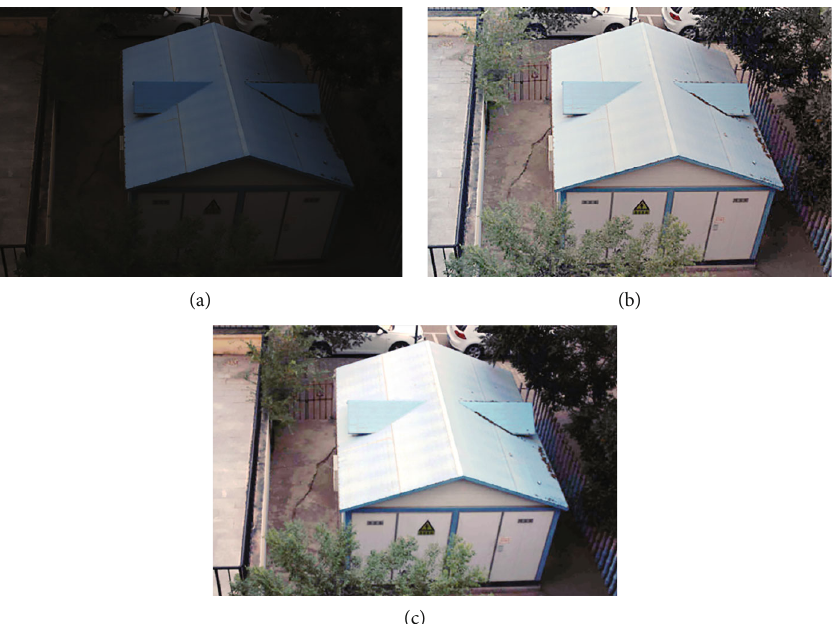
Figure 2: (a) Test chart. (b) MSRCR algorithm. (c) Improved MSR